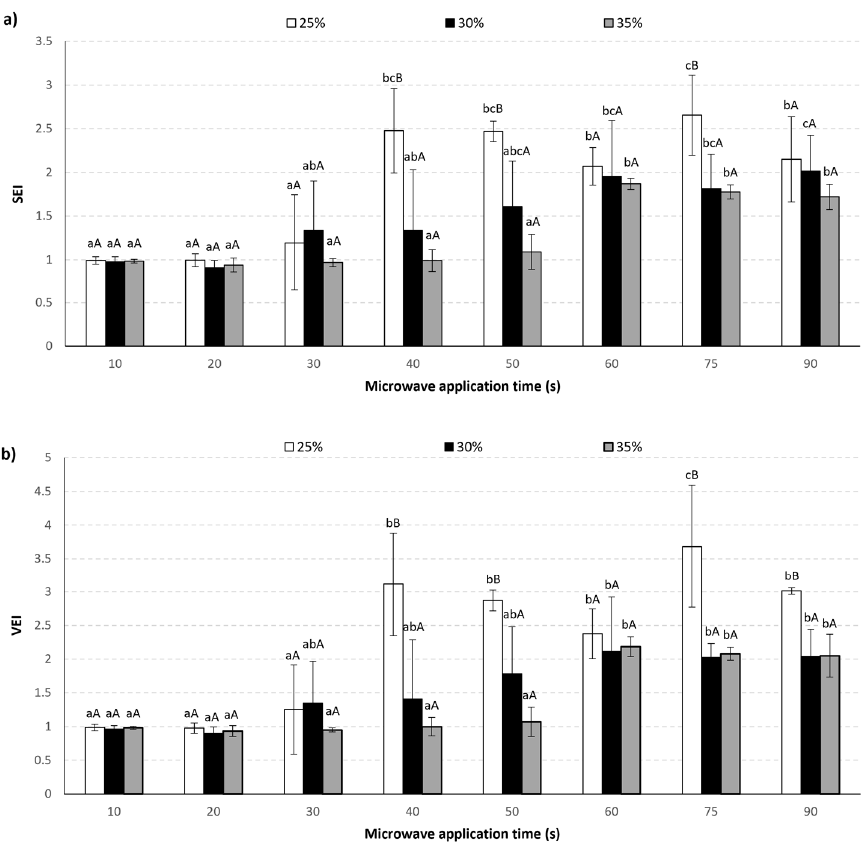
Figure 2. Evolution of SEI (subfigure a ) and VEI (subfigure b ) of pellets as a function of the processing time for three different mixture moisture contents (25, 30, and 35%). Different letters (a, b, and c) represent significant differences ( p < 0.05) by microwave expanded application time and also (A, B) represent significant differences ( p < 0.05) by water content.